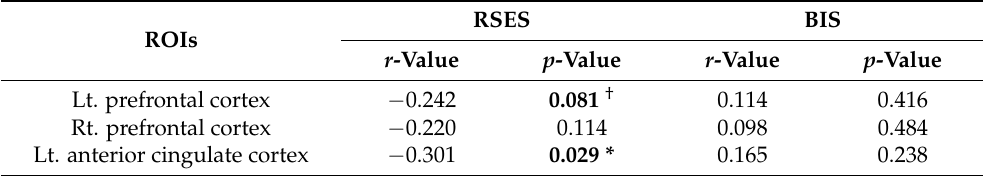
Table 3. Correlation coefficients between regional [ 11 C]PK11195 BP ND values and clinical scores for the entire subject group ( n =